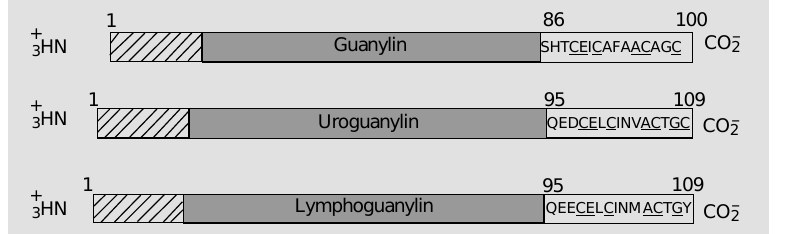
Figure 2 - Prepropeptide structures for guanylin, uroguanylin and lymphoguanylin. The amino acid sequences of the active peptides are shown using the single letter abbreviation of the amino acids within the COOH-terminal regions of each opossum polypeptide.